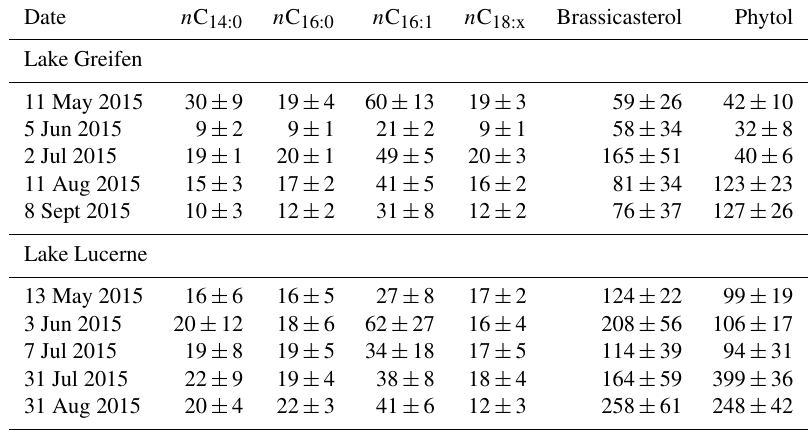
n C 18 : X fatty acids (Fig. 2g and h). Values for α lipid-water were less variable for phytol and brassicasterol than for fatty acids, although they also declined from April to May. Brassicast- erol was always 2 H-depleted relative to fatty acids in Lake Greifen and was depleted in 2 H relative to all fatty acids ex- cept n C 14 : 0 in Lake Lucerne (Fig. 2g and h). Phytol δ 2 H val- ues were the most 2 H depleted of any lipid measured in either lake (Fig. 2g and